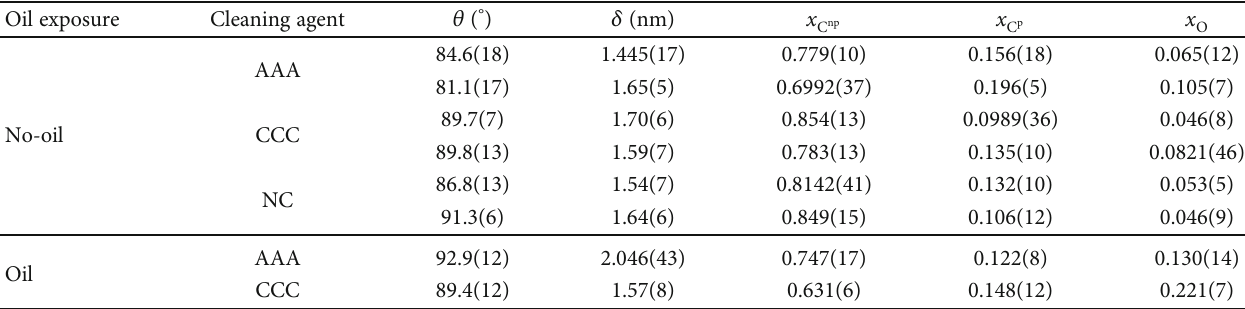
Table 1: Water contact angle θ , adsorbate layer thickness δ , and atom number fractions of oxygen x x C np in the adsorbate layer measured for the di in the last decimal digit.